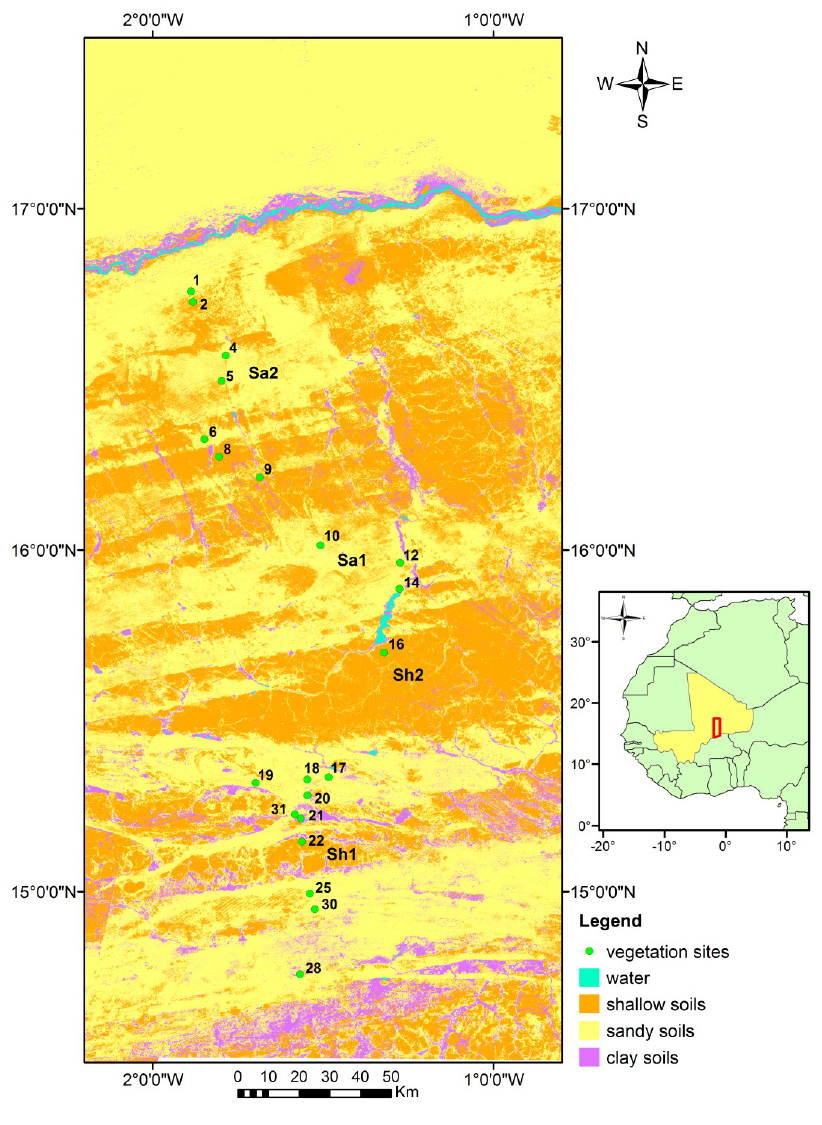
Figure 1. Map of the central Gourma, in Sahelian Mali, portraying the different soil types and the network of long-term ecological survey sites. The map is derived from a supervised classification of soil types and water bodies from Landsat images. The subset shown here corresponds to the area over which GIMMS-3g data are averaged, referred to as the ―Gourma window‖ in this article. Sa and Sa refer to two specific sandy soil units for 1 2 which further investigation was performed (see Section 3.6). Similarly, Sh and Sh refer to 1 2 two specific shallow soil